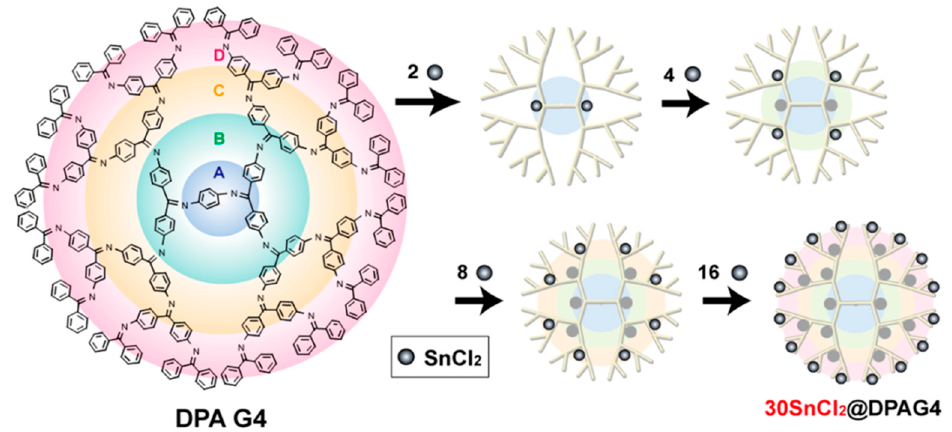
Figure 26. Schematic representation of layer-by-layer stepwise accumulation of metal chloride in phenylazomethine dendrimer (DPAG4). Reprinted with permission from [85]. Copyright 2014 American Chemical Society.